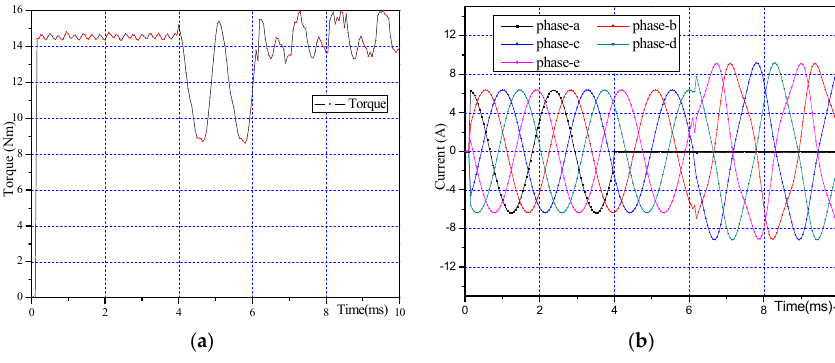
Figure 32. The co-simulation results ( a ) electromagnetic torque and ( b ) current changes when open-circuit fault occurs in phase “a” in serial drive mode (Phase “a” open circuit fault point: 4 ms; injecting the fault-tolerant current point: 6